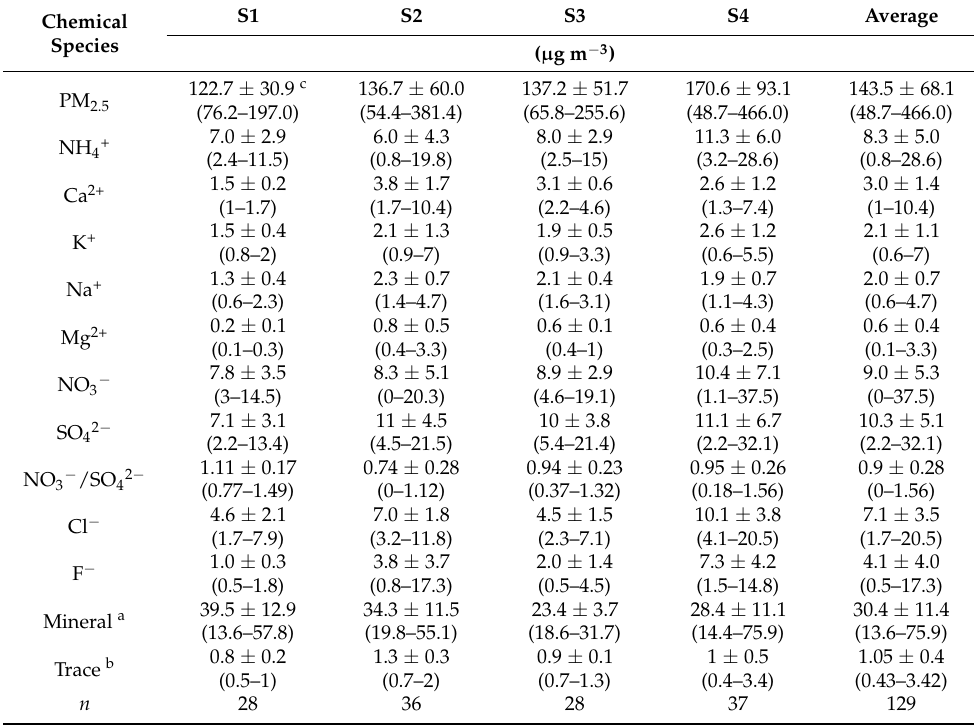
Table 2. Average mass concentrations (mean ± standard deviation) of PM 2.5 and corresponding chemical compositions at four